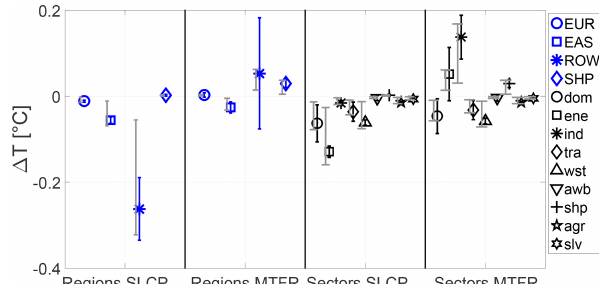
Figure 5. The global temperature response in 2050 in mitigation scenarios relative to the baseline for emission regions and emis- sion sectors for SLCP scen and MTFR scenarios. Error bars repre- senting 1SD are included. The blue and black error bars are cal- culated based on literature values for Gaussian uncertainties in per- component RF, assuming no interspecies correlation, and estimated using a Monte Carlo analysis (100000 pulls), where component forcing values are drawn from within the uncertainty distributions. The blue error bars indicate the uncertainty for the emission regions, the black error bars for the emission sectors. The grey error bars are estimated from uncertainty in the climate sensitivity, based on Monte Carlo analysis (100000 pulls) with values drawn from within the lognormal uncertainty